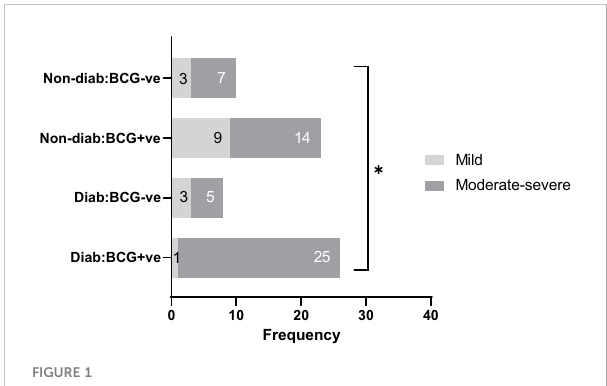
FIGURE 1 Study participants classi fi ed by disease severity (mild and moderate- severe), diabetes status (diabetic, non-diabetic), and BCG vaccination status (positive, negative). * signi fi es p-value